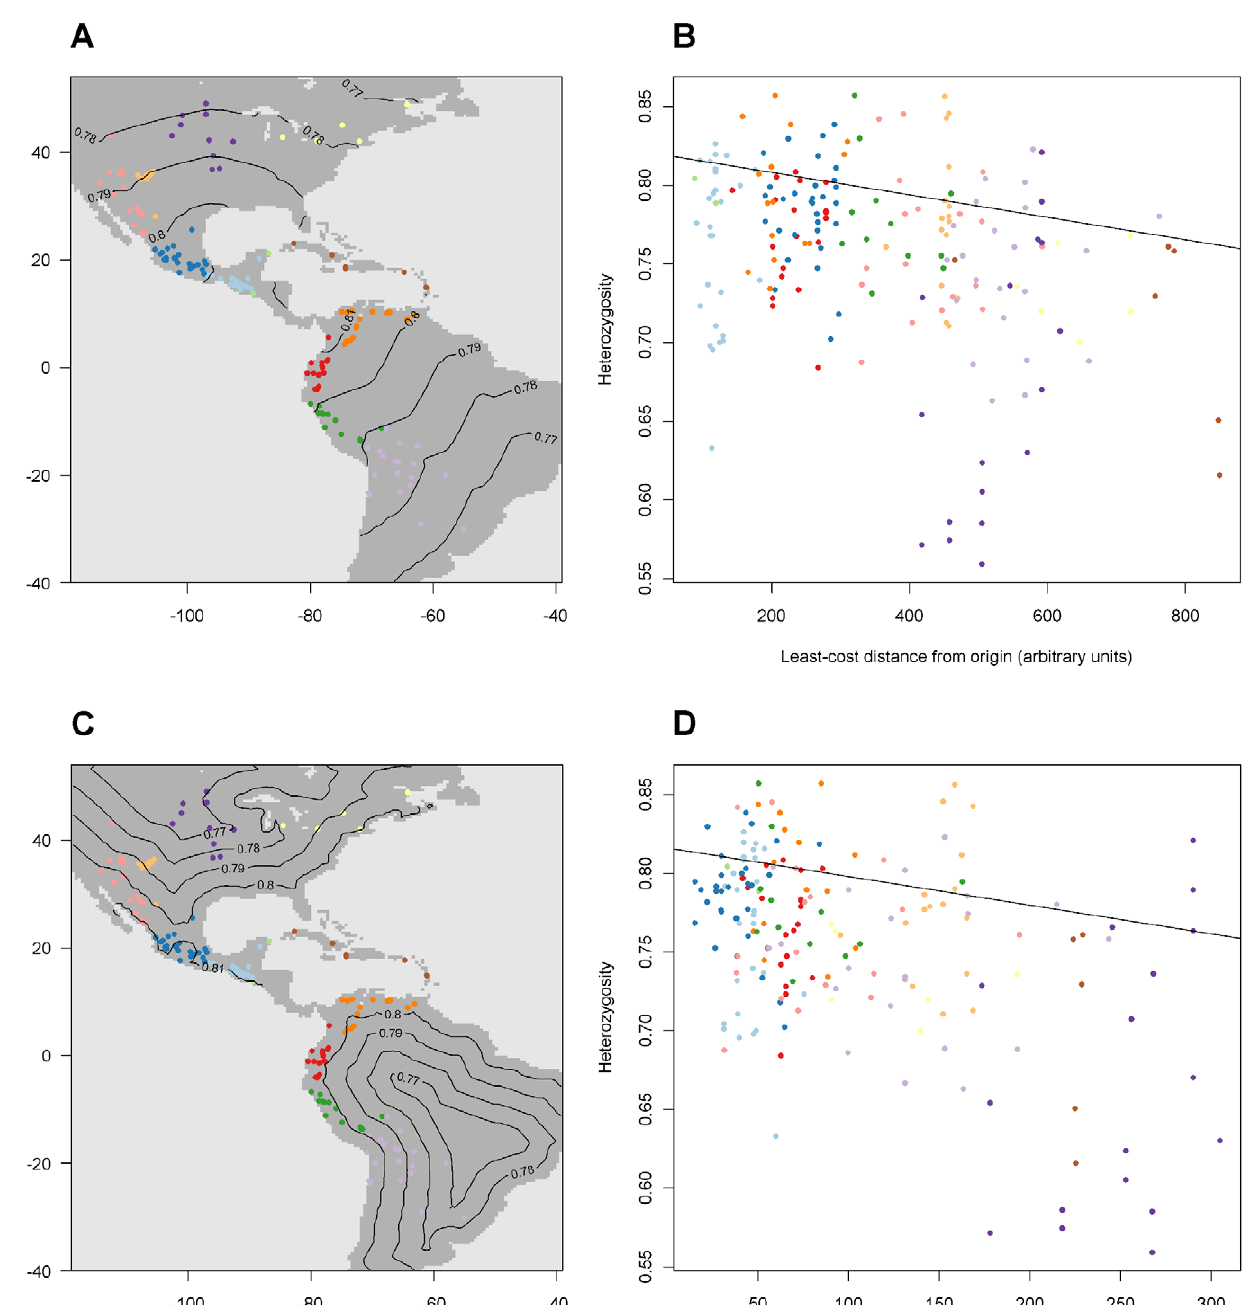
Figure 5. Heterozygosity according to two contrasting Pareto solutions. A. Locations of the genetic observations with isolines indicating modelled heterozygosity values (highest quintile) for solution A. B. Relation between heterozygosity and the least-cost distance for solution A. The colours of the observations correspond to Figure 3A. The line indicates the highest quintile ( t =0.8) predicted by the model. C. Locations of the genetic observations with isolines indicating modelled heterozygosity values (highest quintile) for solution I. D. Relation between heterozygosity and the least-cost distance for solution I. The colours of the observations correspond to Figure 3C. The line indicates the highest quintile ( t =0.8) predicted by the model.